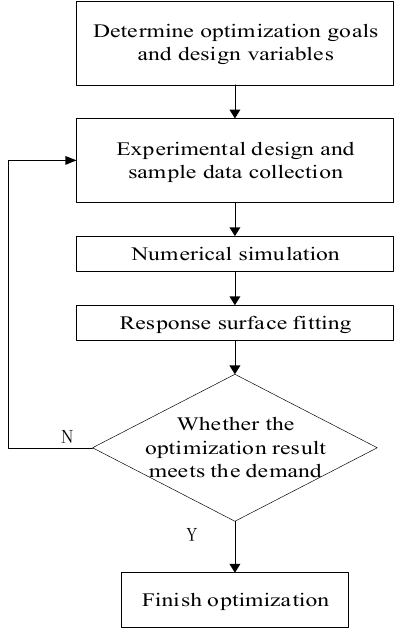
Figure 15. Optimization process.